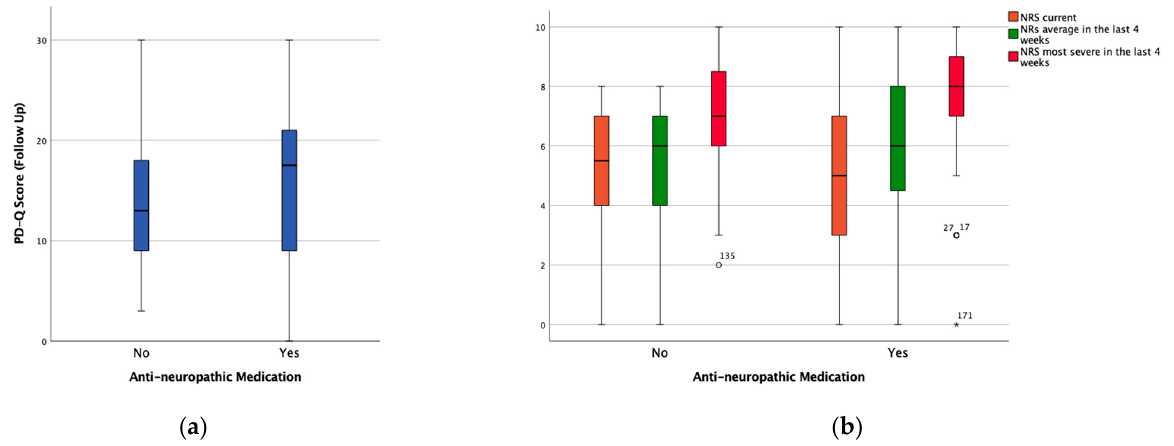
Figure 2. Boxplots showing the distribution of ( a ) the PD-Q score and ( b ) the NRS in the groups with (Yes) and without (No) anti-neuropathic medication at the baseline visit. ◦ and * represent outliers and extreme outliers respectively. Table 2. Summary of all correlations found between the PD-Q score and the three numerical rating scales. NRS scores in all the defined subgroups at both time points in the study. Neuropathic pain